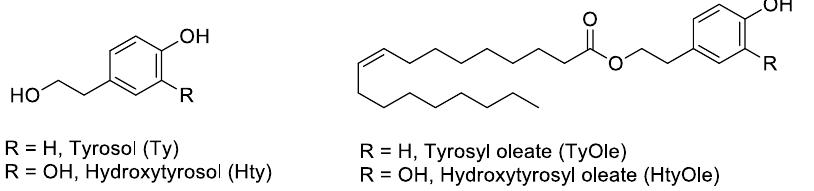
Figure 1. Structure of tyrosol (Ty), hydroxytyrosol (Hty), tyrosyl oleate (TyOle) and hydroxytyrosyl oleate (HtyOle).